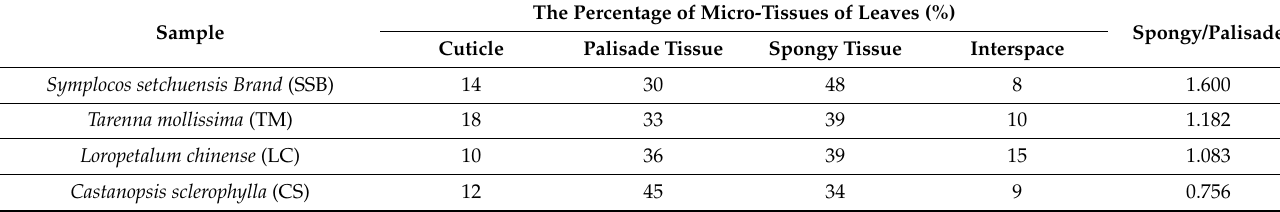
Table 1. The microstructural parameters of the